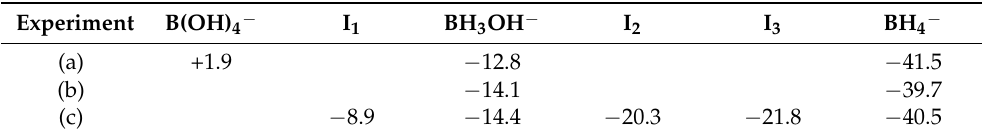
Table 1. Chemical shifts ( δ , in ppm) of the signals observed for the following three experiments: (a) hydrolysis conditions where H 2 O acts as both reactant and solvent; (b) hydrolysis conditions where H 2 O is only a reactant and DMF is used as solvent; (c) hydrolysis conditions where DMF is the solvent and H 2 O is a reactant in excess. I 1 to I 3 indicates the intermediates associated to the quartets observed in the spectra collected for the experiment